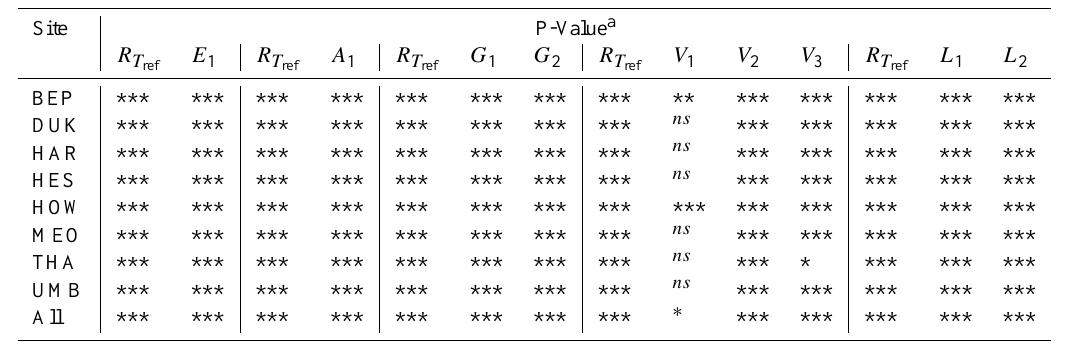
Table A2. Significance levels